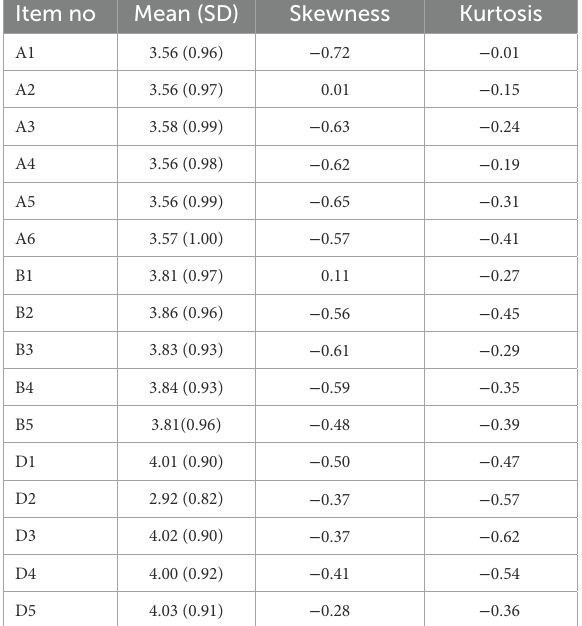
TABLE 3 Results of univariate normality